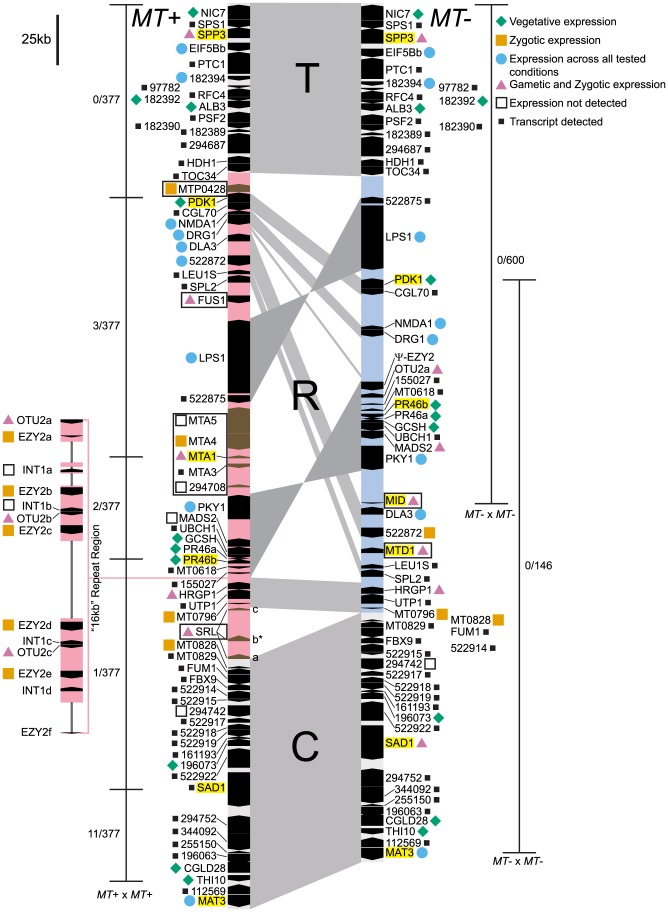
Diagram of the Chlamydomonas reinhardtii mating locus.The MT+ (left side) and MT− (right side) haplotypes are aligned vertically with regions of synteny connected by gray shading. The three major domains are labeled as T, (Telomere Proximal, ∼82–84 kb), R (Rearranged, ∼204–396 kb), and C (Centromere Proximal, ∼116 kb). The R-domain section of each haplotype is shaded light pink (MT+) or blue (MT−). Genes are designated by black or brown pointed rectangles with pointed ends showing their relative orientation. Gene names are shown to the left or right of each gene symbol. The 16 kb repeat region in MT+ is depicted as an expansion to the left of the main diagram with unassembled regions indicated by thin lines. MT+ and MT− limited genes are boxed. Names of genes used for population studies are highlighted in yellow. Gene expression patterns compiled from this study, from [19], and from publicly available transcriptome data are denoted by colored shapes as follows: blue circle, all stages; green diamond, vegetative; pink triangle, gametic and zygotic; orange square, zygotic; open square, not detected; small black square, transcript detected but expression pattern not determined. The expression pattern shown for the SRL region is specific to the SRLb gene that is indicated by an asterisk. The thin bars to the left and right of each diagram show the region where recombination was measured in MT+×MT+ or MT−×MT− homozygous crosses. Crosshatches show markers that were scored for recombination and numbers of recombinants/total progeny scored are shown next to each recombination interval.